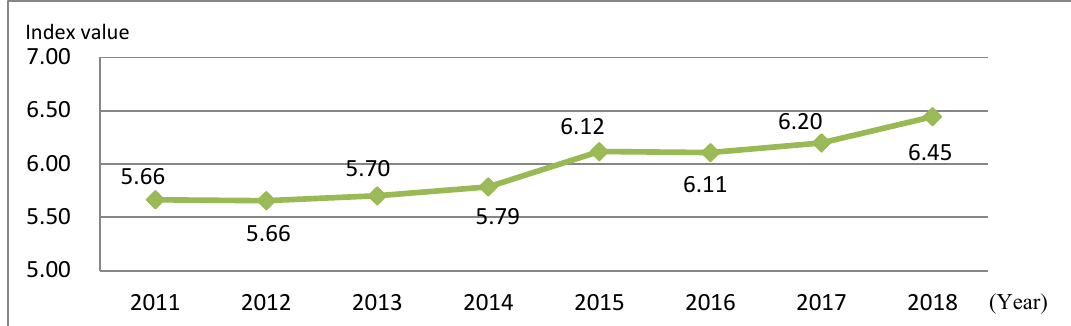
Fig. 1: Indonesia's inclusive green growth (in the index) Fig. 1: Indonesia’s inclusive green growth (in the index) (CBS, 2020; NDPA, 2020; MEF,